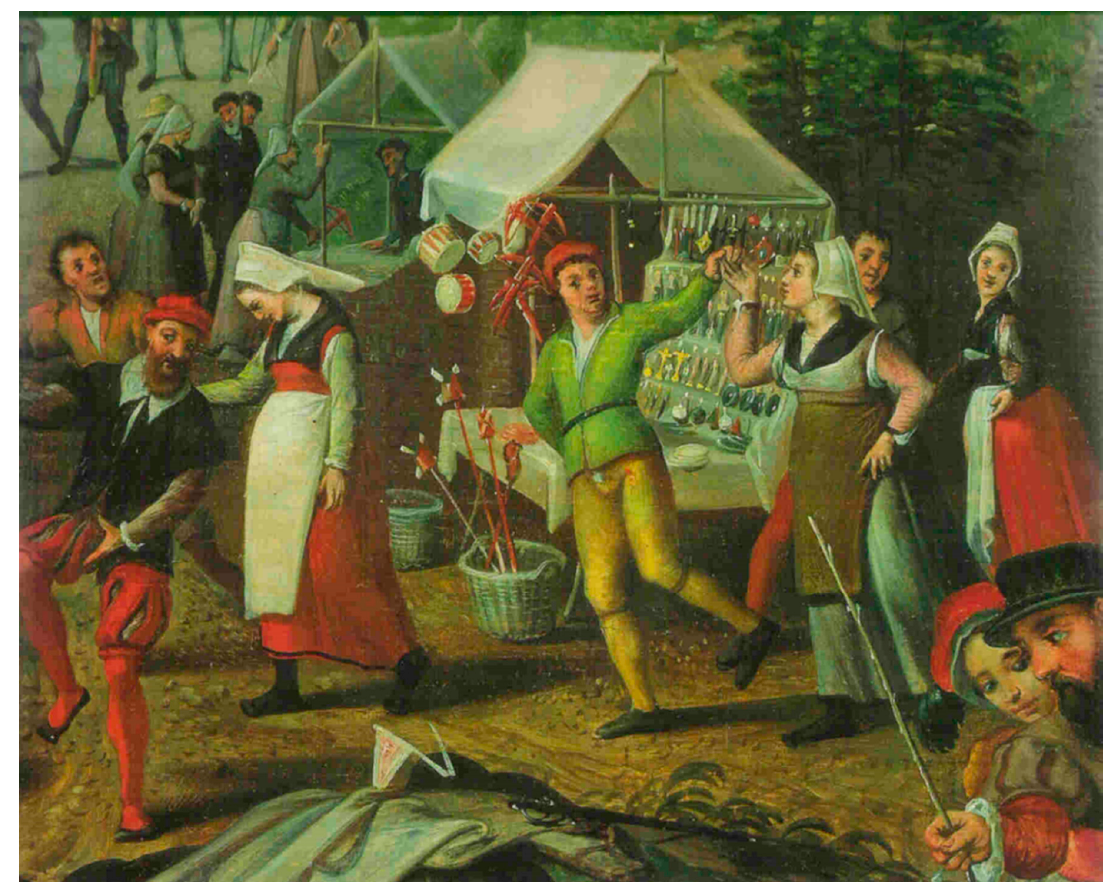
Figure 5. Pieter Aertsen, Detail of Retour d’un pèlerinage à Saint Antoine, c. 1500, Muséees Beaux-Arts de Belgique, Brussels. Photo: Author.